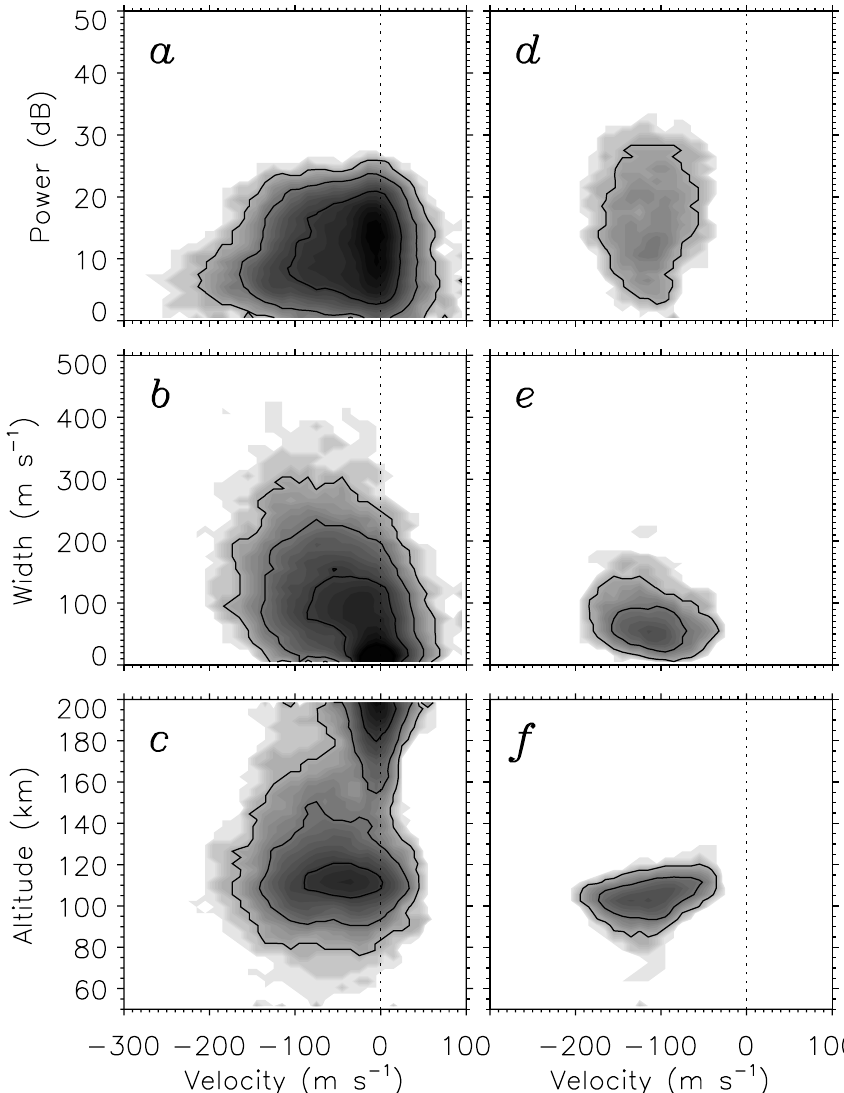
Fig. 8. Similar to Fig. 7, though only for the interval 02:30 to 03:03UT, and concentrating on low Doppler shifts. Panels (d)–(f) show the backscatter characteristics of echoes which comprise the radar arc, whereas panels (a)–(c) show the characteristics of all other